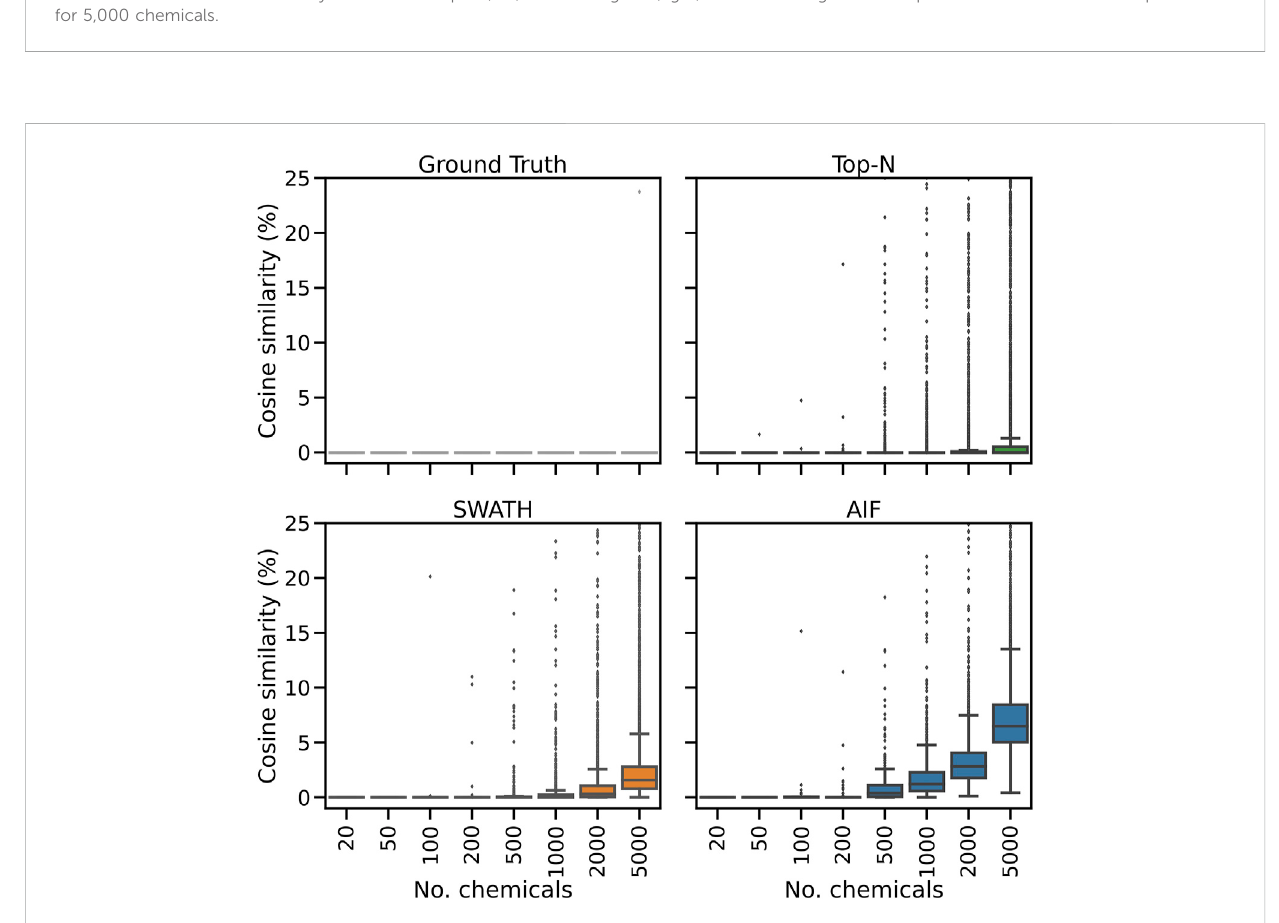
FIGURE 5 The distribution ofpairwisecosinesimilarity scoresof theground truth(truechemical spectra), and fragmentationspectra fromTop-N,SWATH and AIF. The plot y-axes are truncated at 25%